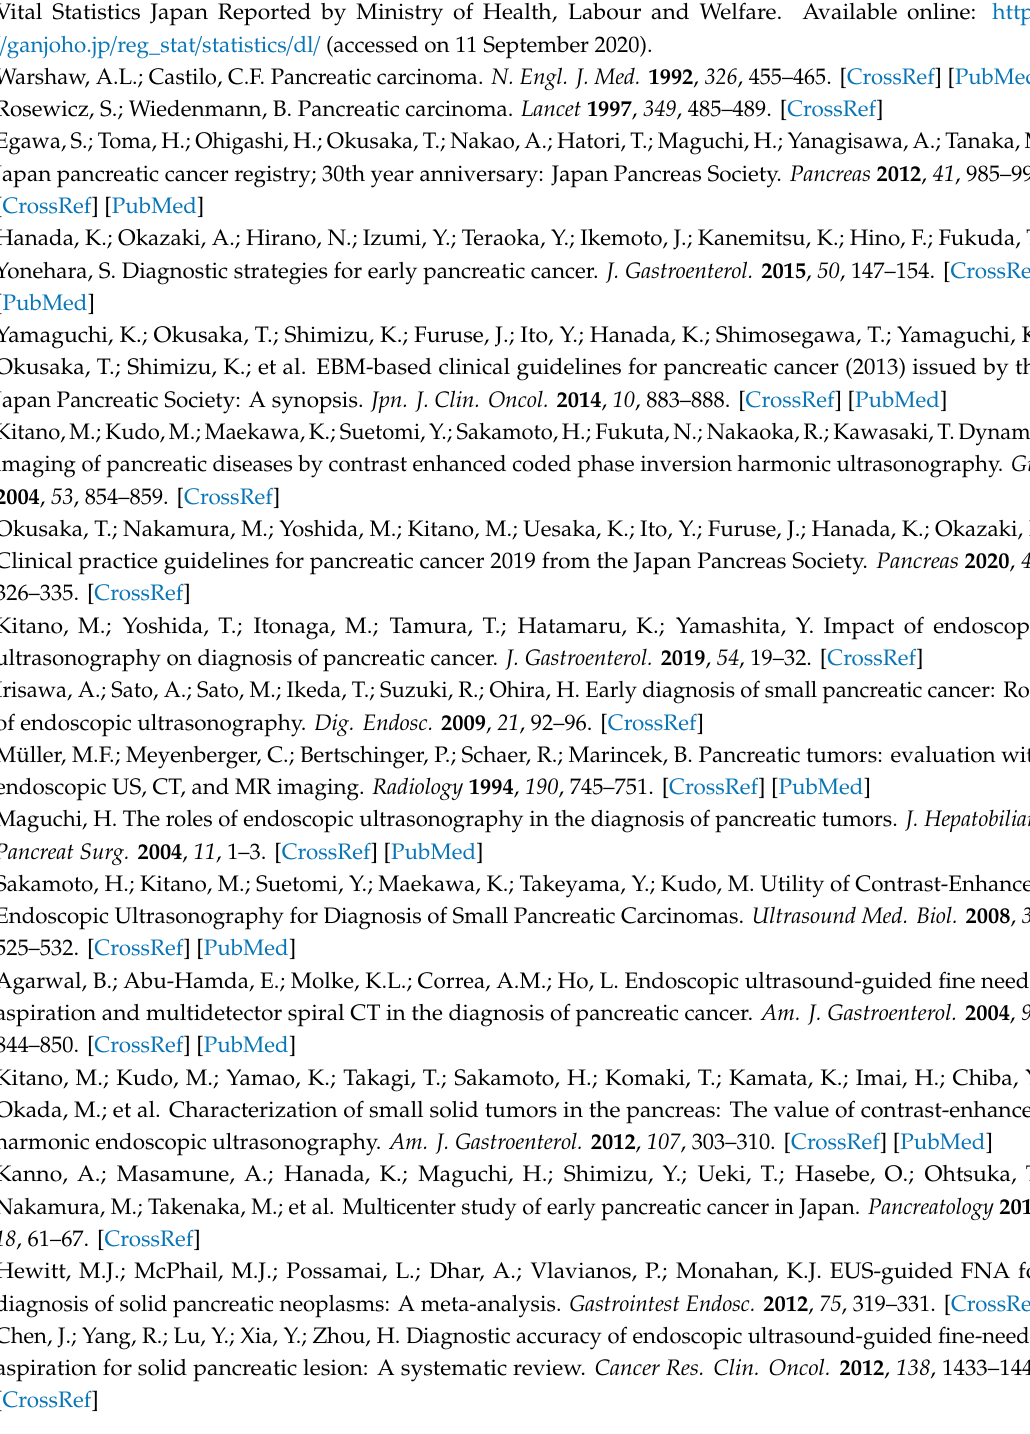
PC, pancreatic cancer; EUS, endoscopic ultrasonography; CT, contrast computed tomography; MRI,